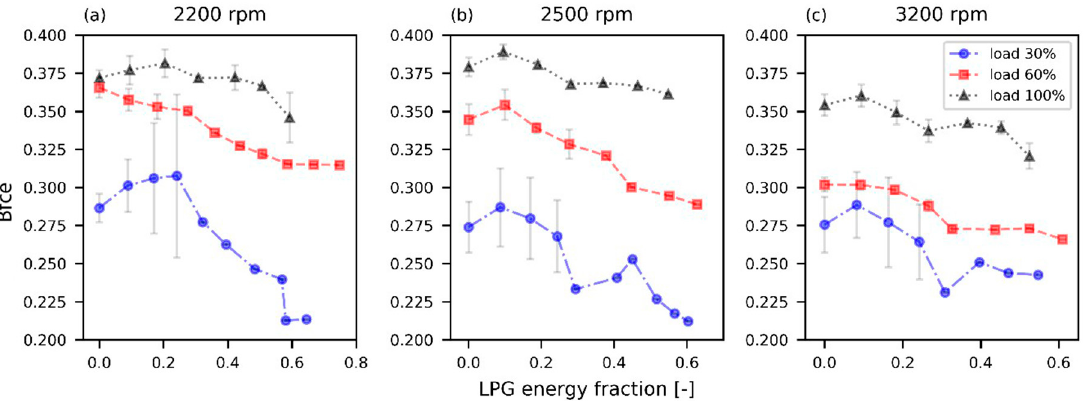
Figure 4. Brake fuel conversion efficiency v/s LPG energy fraction at ( a ) 2200 rpm, ( b ) 2500 rpm, and ( c ) 3200 rpm. ( c ) 3200